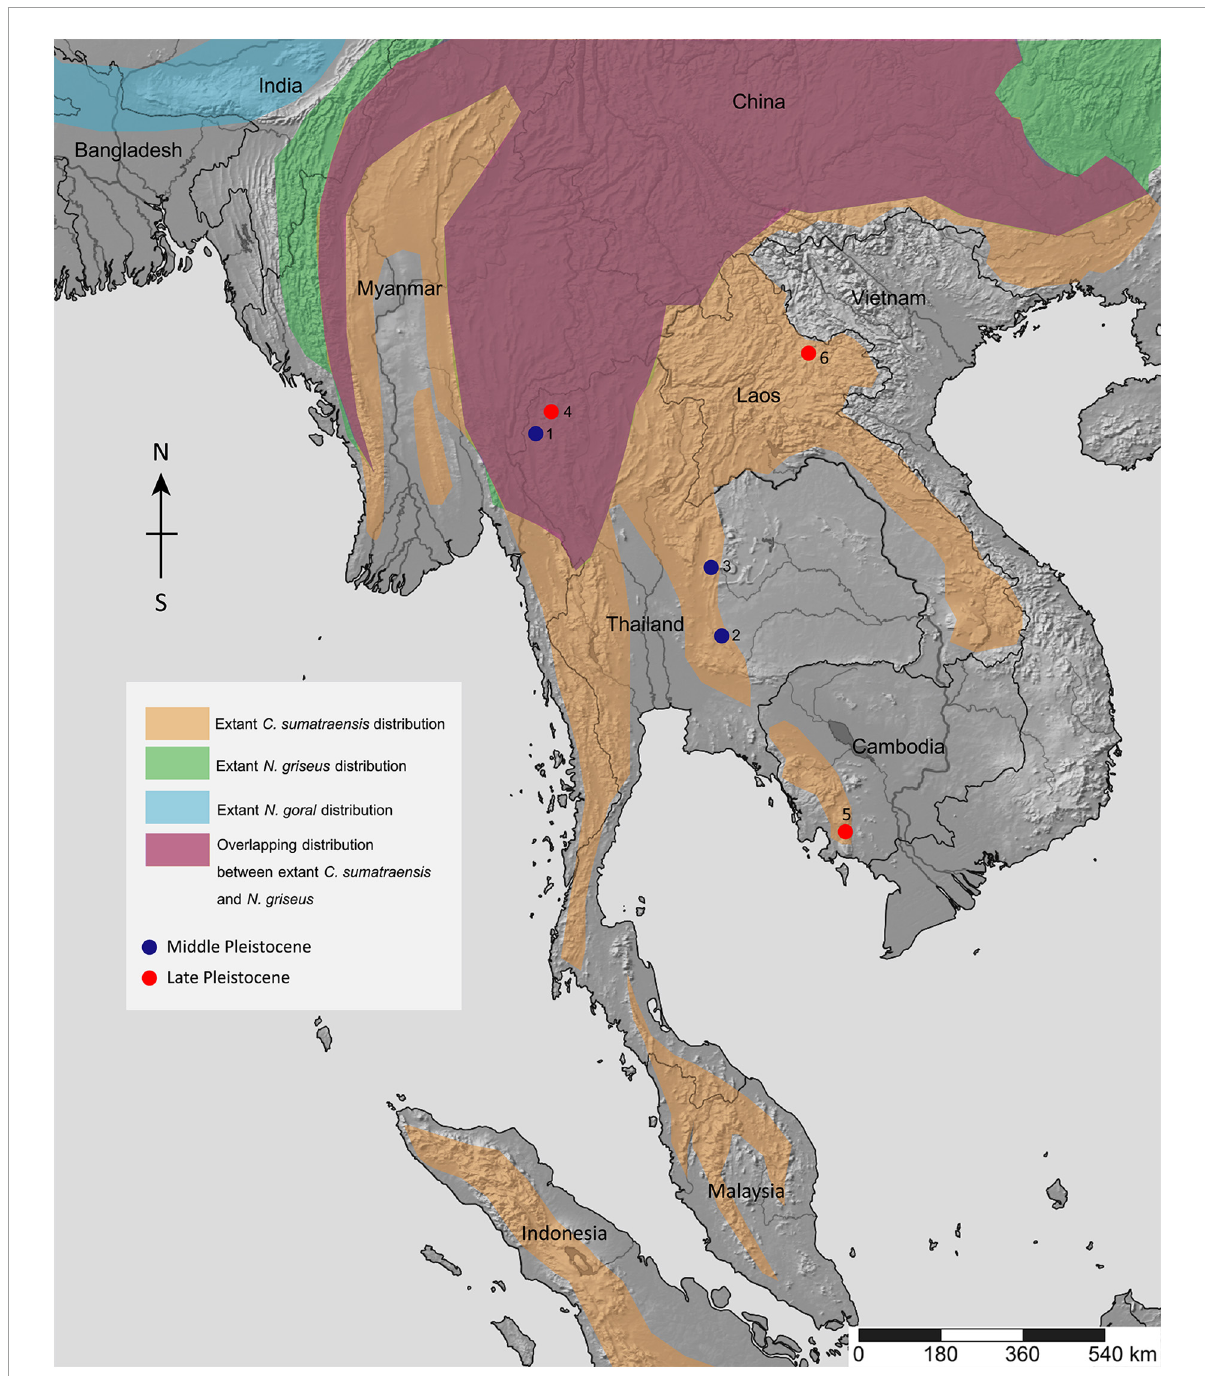
FIGURE1 The distribution of extant and Pleistocene caprines in Southeast Asia, the eastern region of South Asia, and South China [modified after Suraprasit et al. (2020)]. Six paleontological and archeological sites in Southeast Asia mentioned in this study: 1 = Pha Bong, Mae Hong Son (Bocherens et al., 2017); 2 = Khok Sung, Nakhon Ratchasima (Suraprasit et al., 2016); 3 = Tham Wiman Nakin, Chaiyaphum (Suraprasit et al., 2021a); 4 = Tham Lod Rockshelter, Mae Hong Son (Wattanapituksakul et al., 2018); 5 = Boh Dambang, Cambodia (Bacon et al., 2018b);